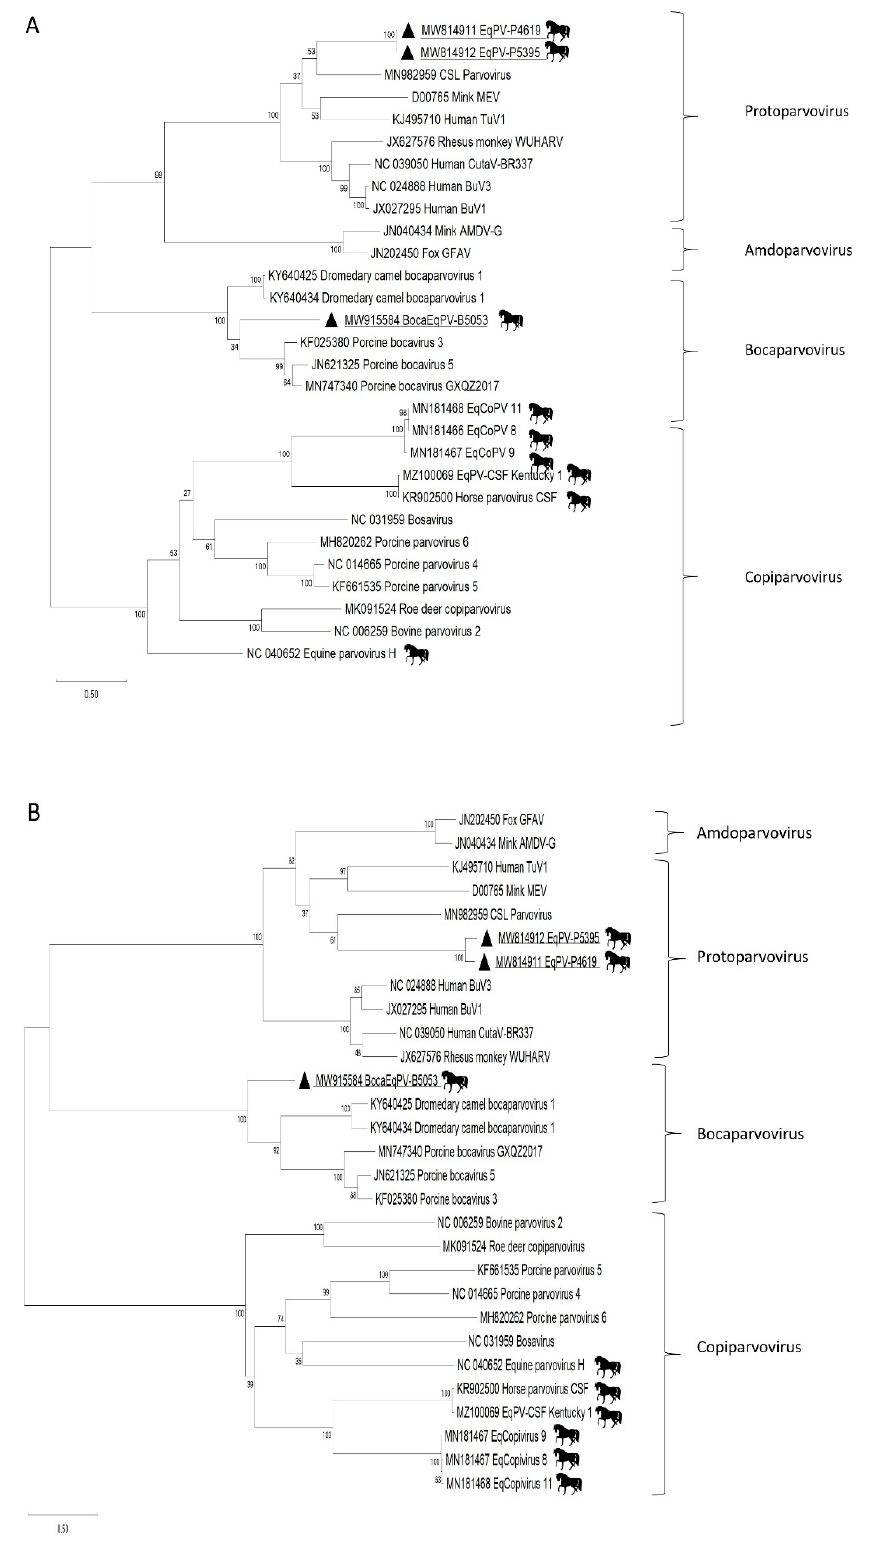
Figure 1. ( A ) Phylogenetic analysis of equine parvoviruses NS1. ( B ) Phylogenetic analysis of equine parvoviruses VP1. The scale indicates amino acid substitutions per position. The amino acid (aa) pairwise alignments were performed with Geneious R10 software using the in-built MAFFT algorithm. The phylogenetic trees were constructed using the maximum likelihood method with substitution model: Le Gascuel 2008 based model with gamma-distributed (G+) for NS1 and VP1 in MEGA software version X. Viral taxa from this study are highlighted with